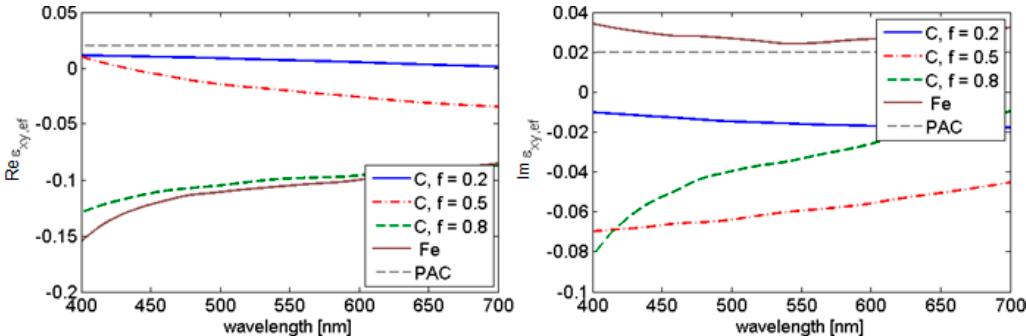
Figure 3. O ff -diagonal components of e ff ective permittivity for cylindrical Fe nanoparticles in Figure 3. Off-diagonal components of effective permittivity for cylindrical Fe nanoparticles in polyacrylate (a = height / diameter = 10 / 5 nm, fill factor 0.2, 0.5, 0.8) compared to pure Fe [19] polyacrylate (a = height/diameter = 10/5 nm, fill factor 0.2, 0.5, 0.8) compared to pure Fe [19] and and polyacrylate. polyacrylate.